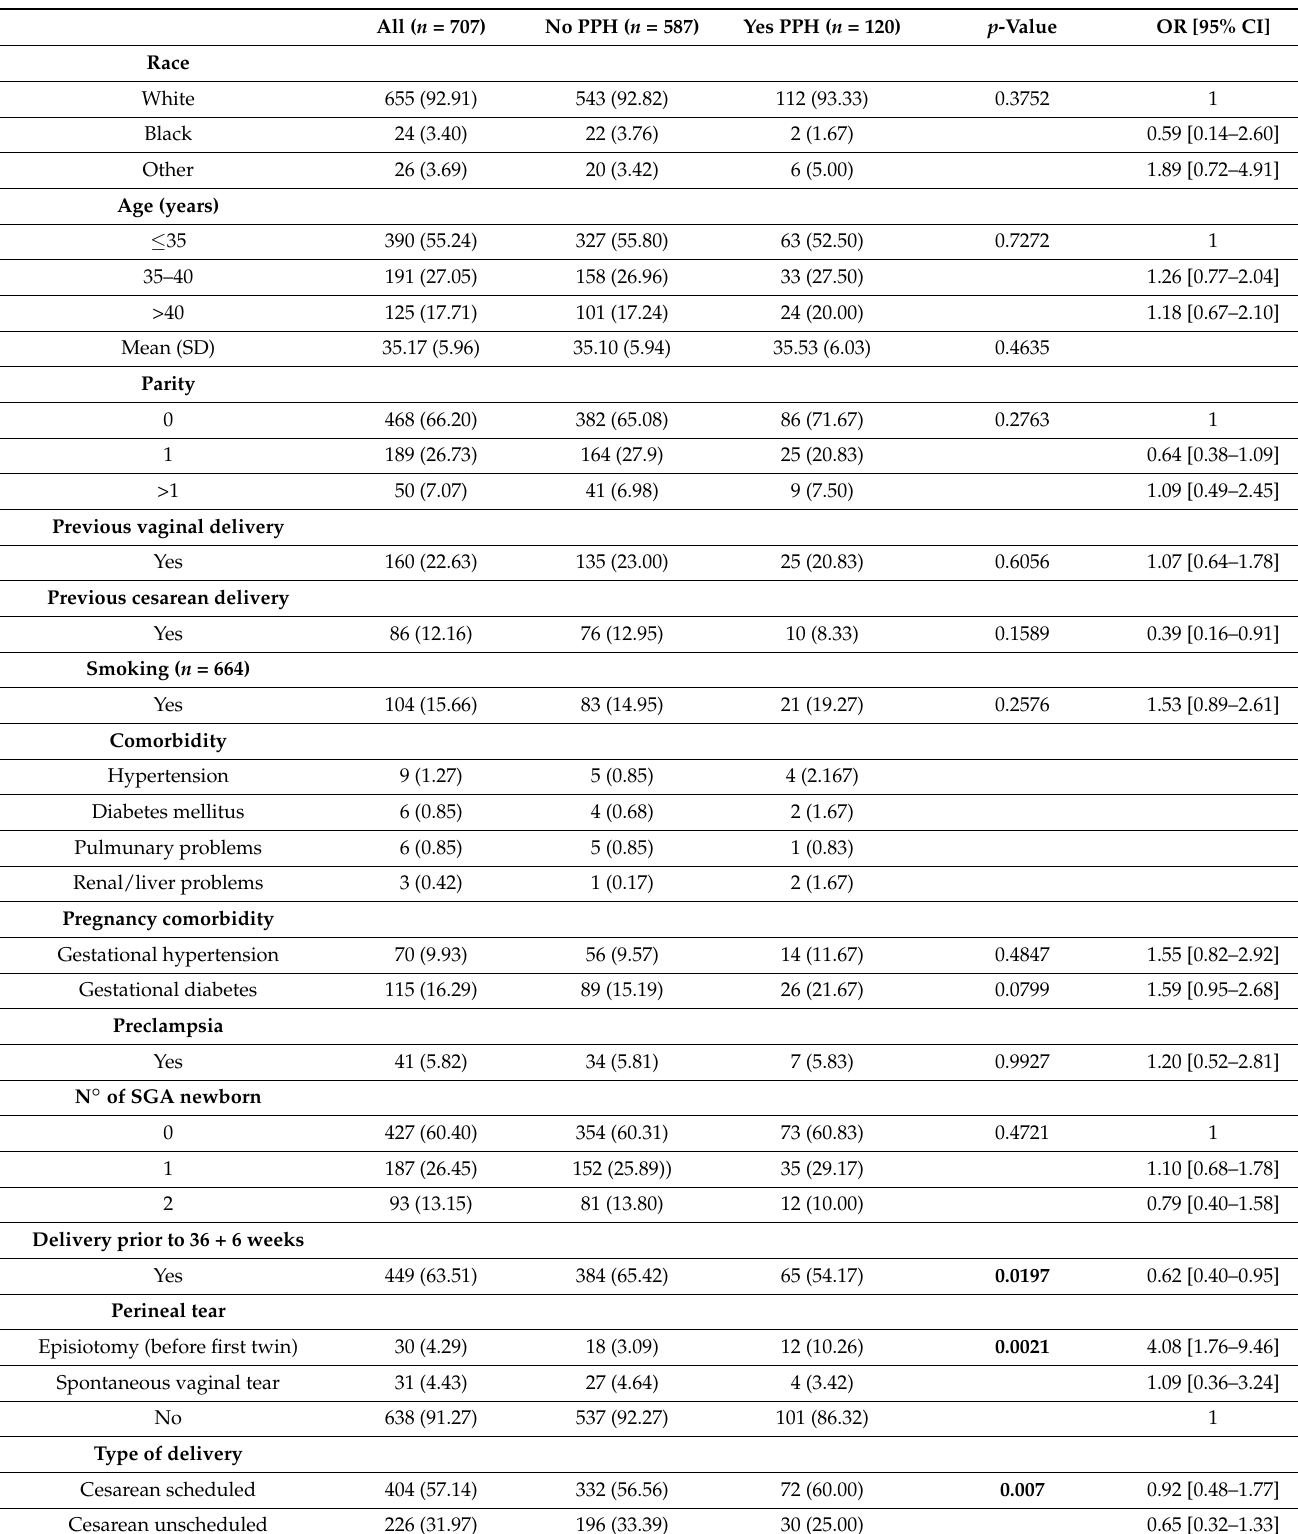
Table 1. Maternal and peripartum characteristics of all women and separately for subjects with and without postpartum hemorrhage (PPH). p -values obtained by chi-square or Fisher exact test for categorical variables and t -test or Wilcoxon test for numerical ones are reported. The odds ratios (ORs) obtained by univariate logistic regression model using the presence of HPP as outcome are also shown with their 95% confidence intervals [95%